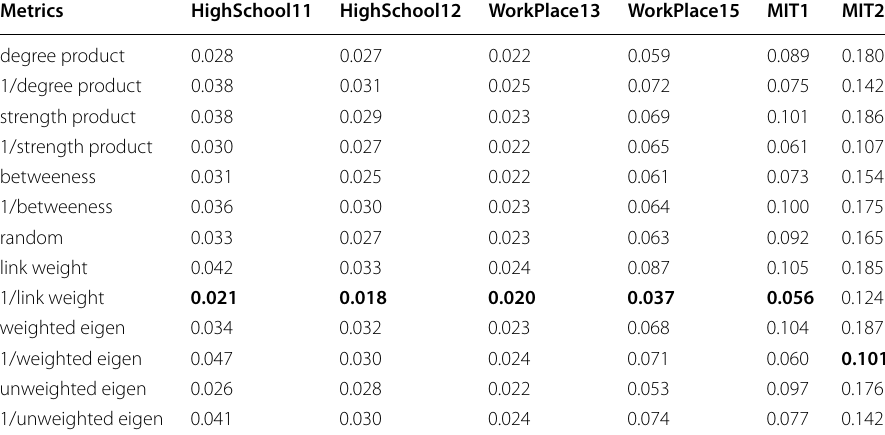
The lowest average prevalence value for each dataset is highlighted in bold